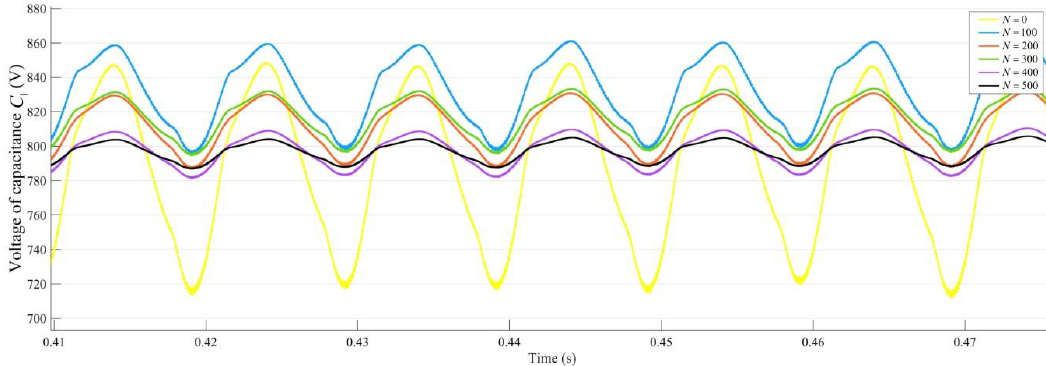
Figure 9. Voltage waveforms of Z-source network capacitance C 1